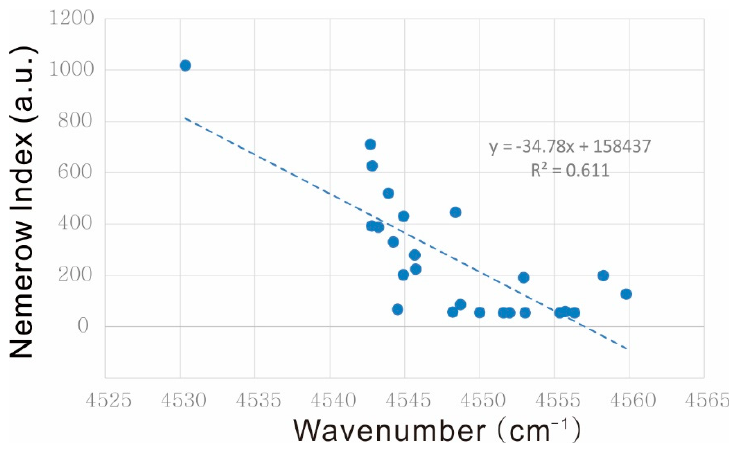
Figure 8. Linear correlation between diagnostic NIR bands and Nemerow index value.